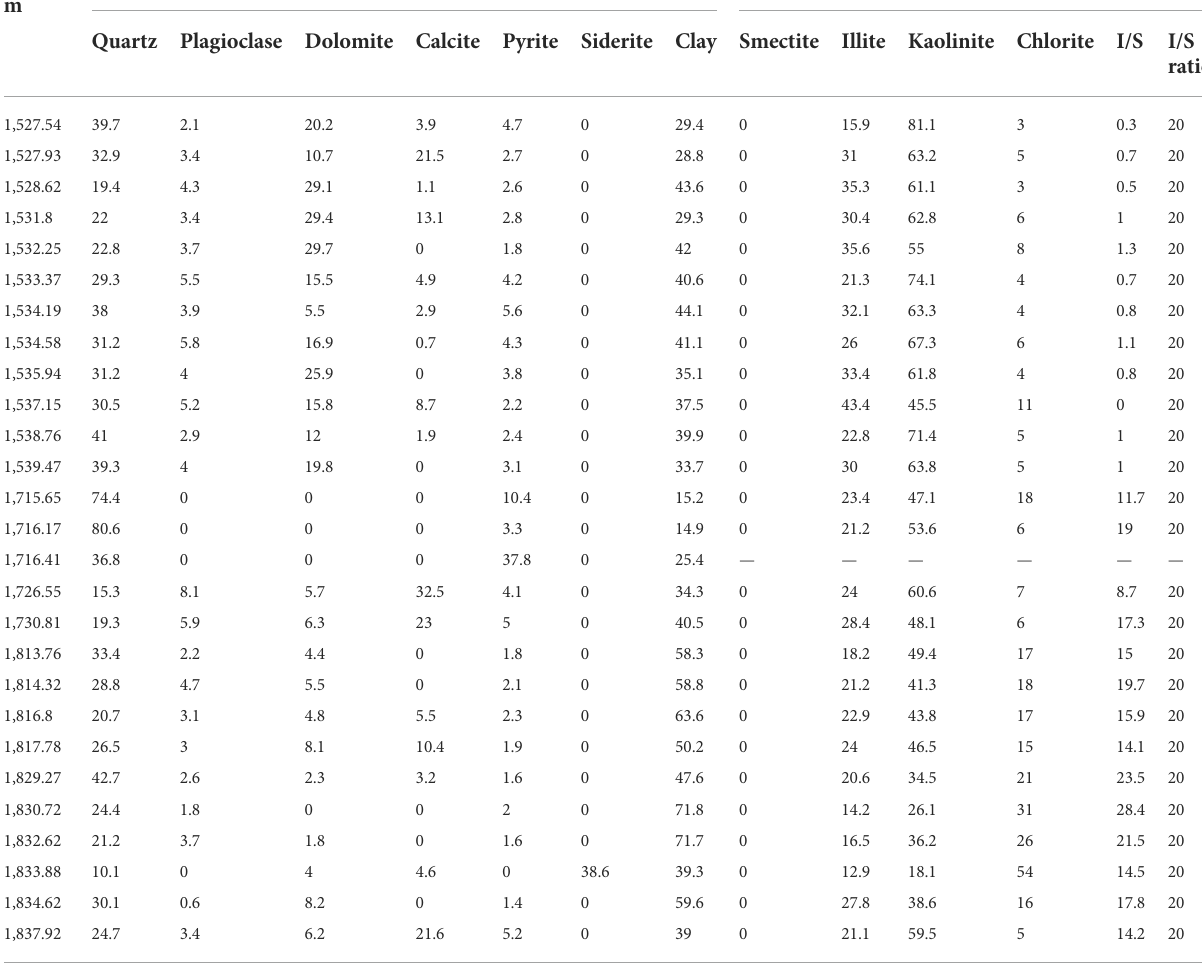
TABLE 3 Mineral compositions of the Jiusi shale samples from YS302. Depth/ Mineral constituent content m